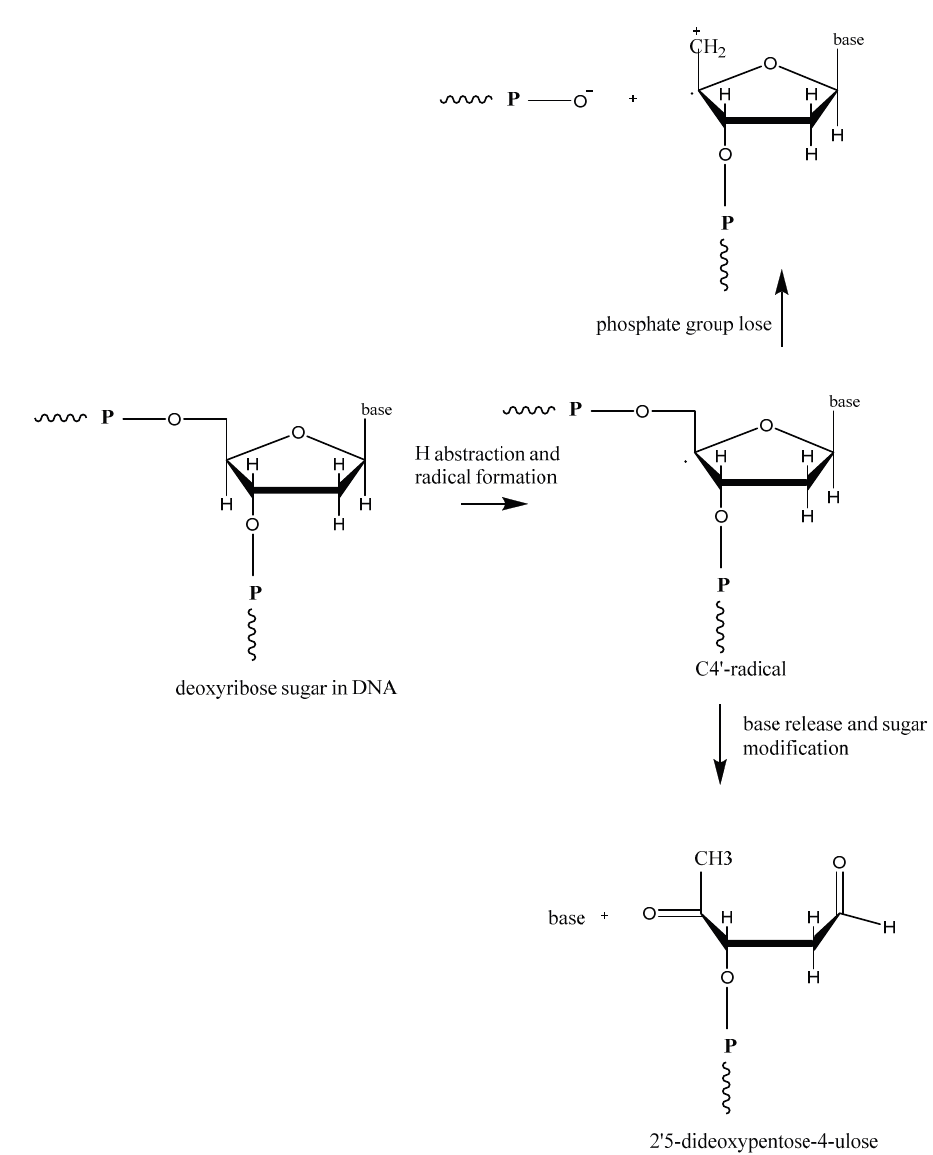
Figure 5. Sugar-phosphate backbone damaging reactions on DNA, including C4 ʹ -radical formation from deoxyribose sugar, base release, sugar modification, and loss of phosphate